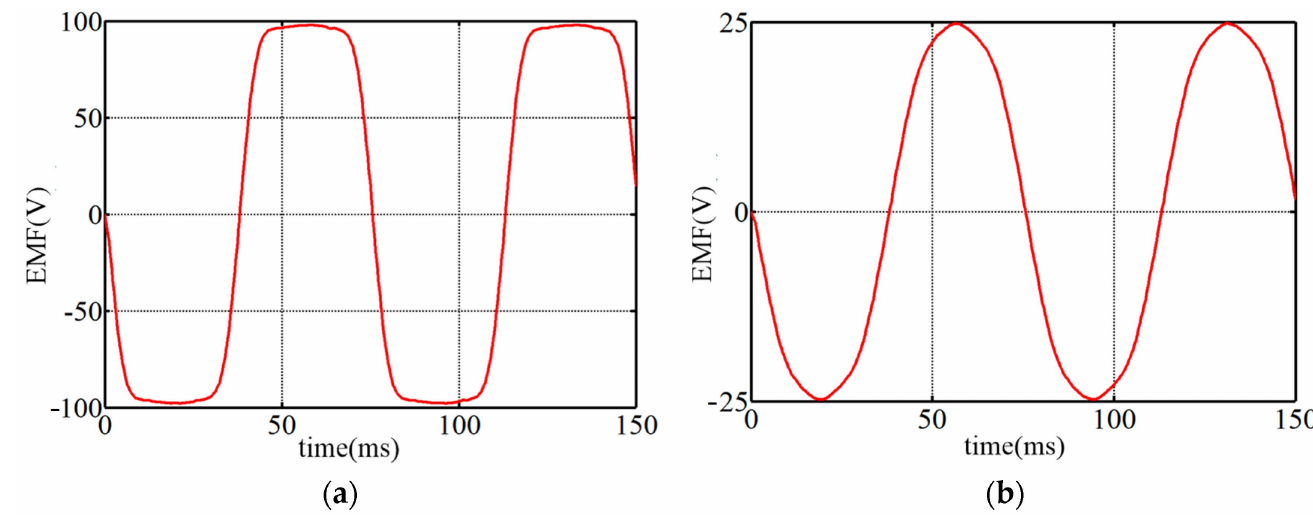
Figure 10. Simulation of air gap magnetic density of two FPMSMs: ( a ) THI − FPMSM; ( b ) SIN − FPMSM.